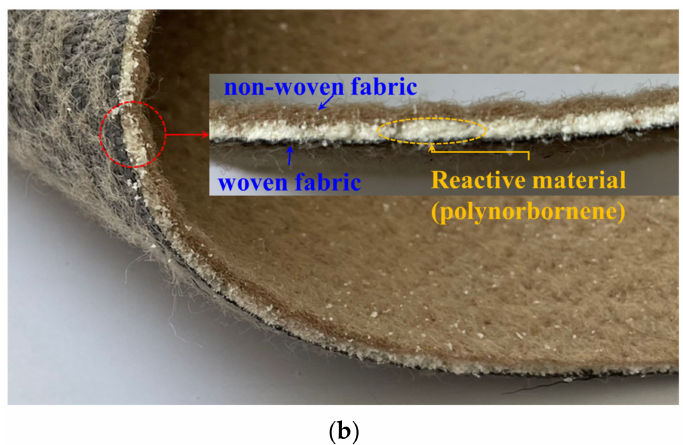
Figure 1. Hybrid liner: ( a ) Conceptualization; ( b ) Gelation over time (modified from [32]).